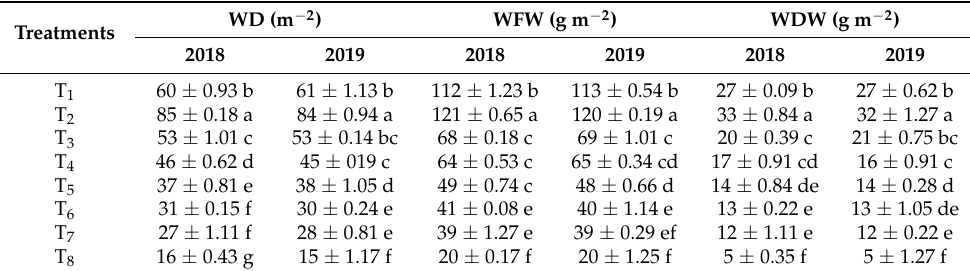
Table 1. Weeds density (WD), fresh (WFW) and dry (WDR) weights in maize, black gram and green gram sole crops and in maize-gram intercropping systems under semi-arid conditions.